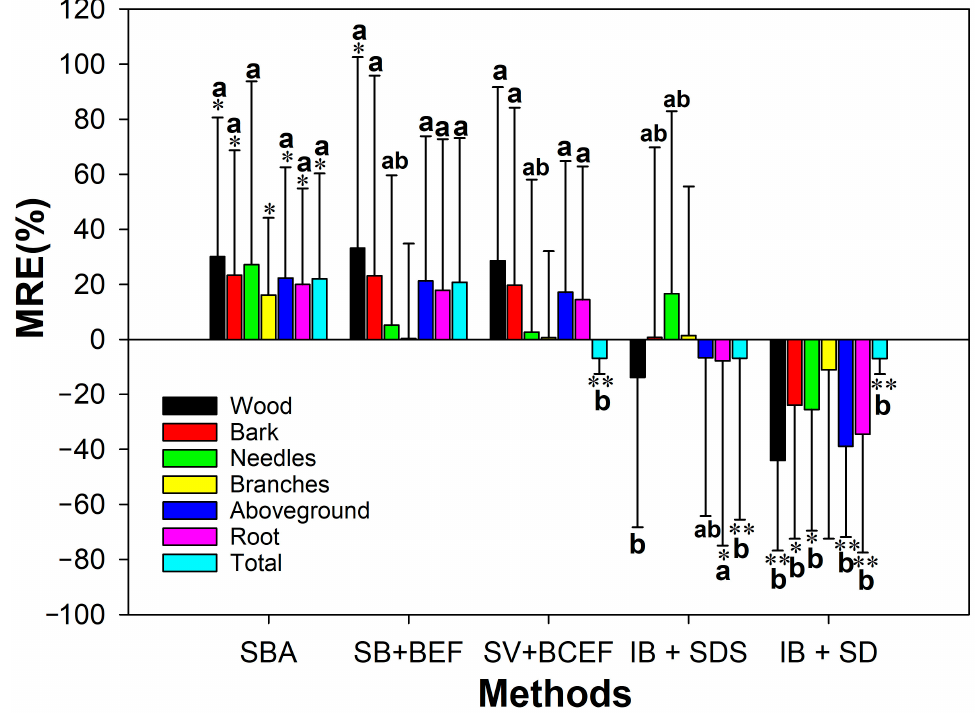
Figure 3. Mean relative error (MRE) of five methods for the different components. The statistical test results of the significant differences of MREs from zero: * and ** represent the significance levels of 0.05 and 0.01, respectively. The letters a, ab, and b indicate the significance of the same component between different methods at the significance levels of 0.05.